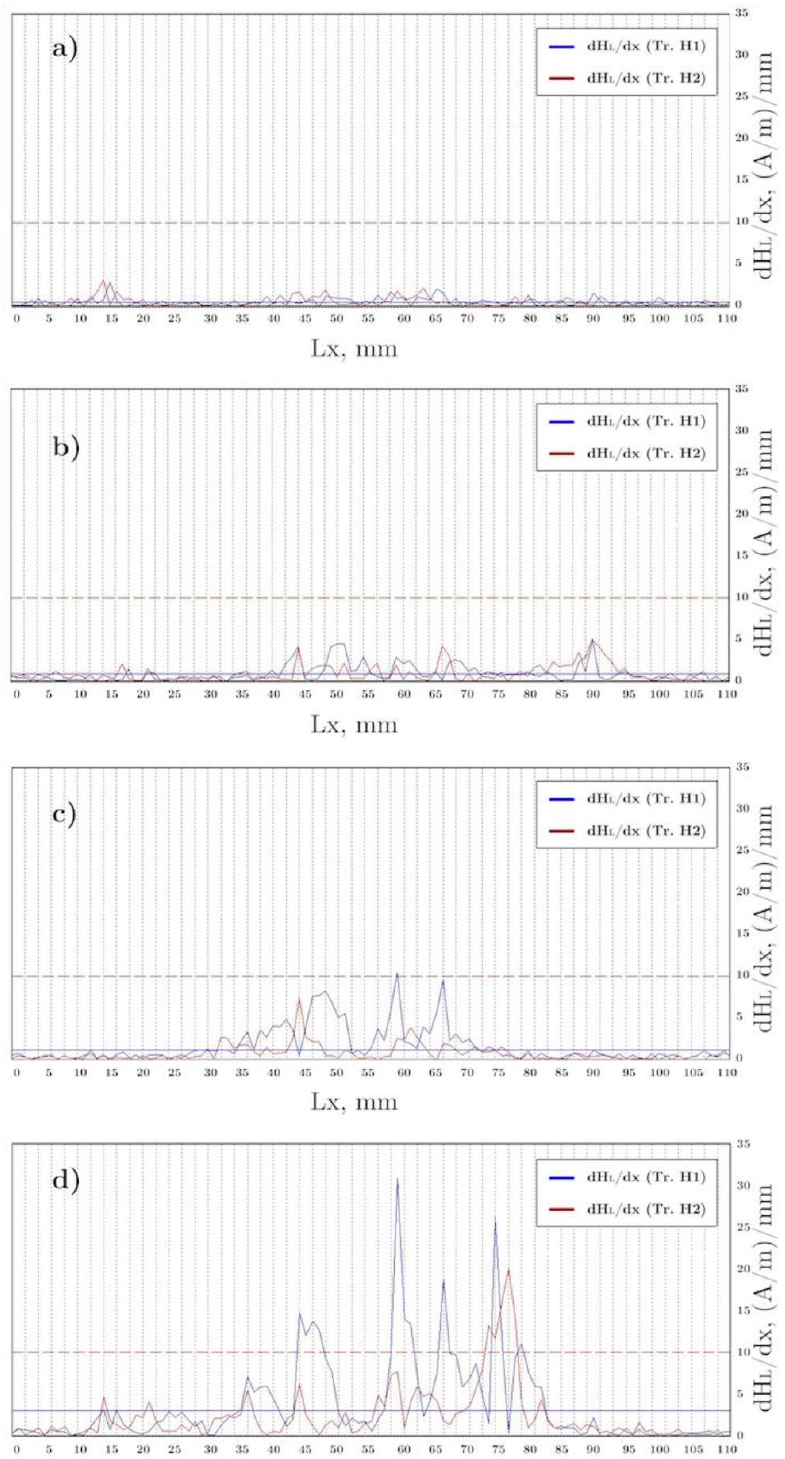
Figure 15. Magnetograms of trajectories H1 and H2 in specimens ( a ) DC1, ( b ) DC2, ( c ) DC4 and ( d ) DC5.